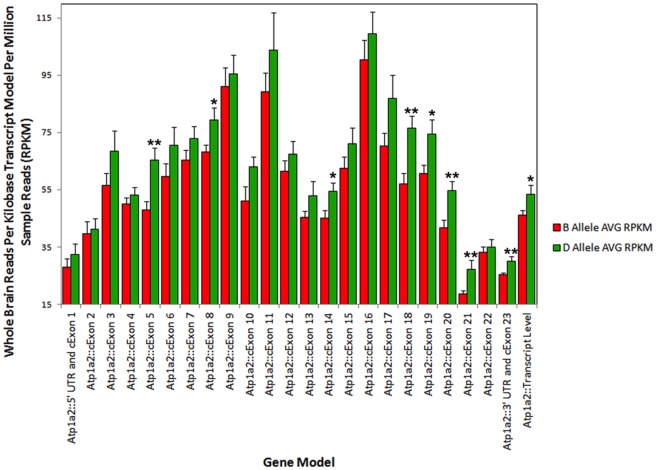
Validation of strain variation in Atp1a2 expression in the BXD population by RNA-seq.Normalized (RPKM) values in whole brain are shown for the B (N = 20) and D allele (N = 11) for each feature of Atp1a2 RefSeq transcript model. “Transcript level” (far right on X-axis) measures expression for the entire Atp1a2 transcript based on the NCBI RefSeq transcript model. Asterisks denote the level of significance with single and doublets representing p-values less than 0.05 and 0.01, respectively. There is a trend toward higher expression of all transcript features associated with the D allele and this difference achieves statistical significance for exons 5, 8, 14, 18, 19, 20, 21, and exon 23 and the 3′ UTR. Consequently, the D allele is associated with higher expression of the entire Atp1a2 transcript in whole brain.